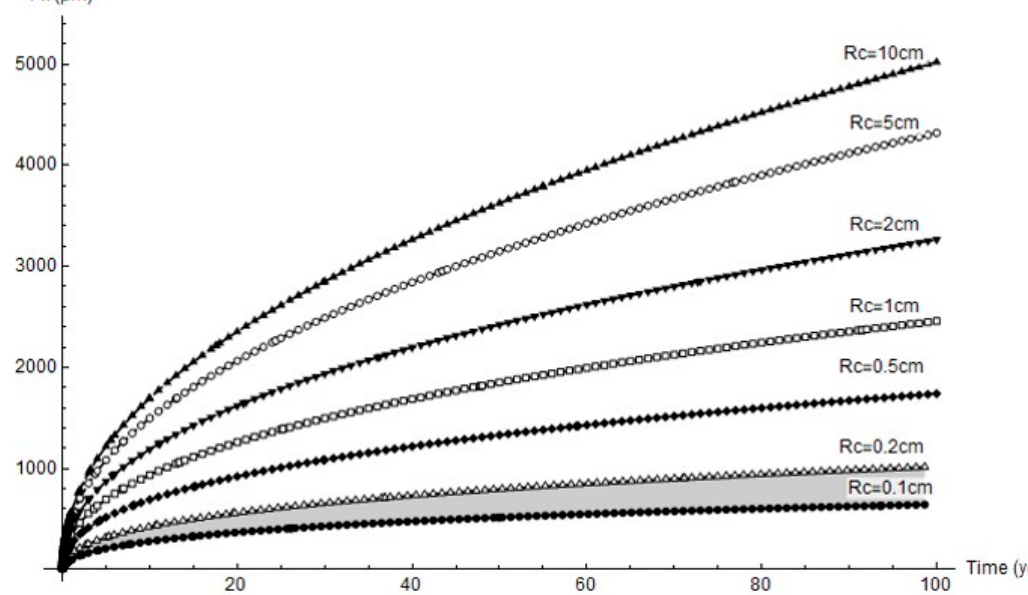
Figure 12. Predicted variation in pit depth for different cathode areas over long time periods (grey shading = range of experimental findings).